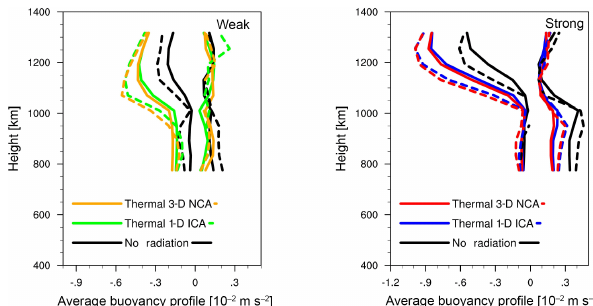
Figure 6. Positive and negative buoyancy profile sampled at 50– 58min of the simulation in the cloudy area. Dashed lines show the symmetric cloud; solid lines show the non-symmetric